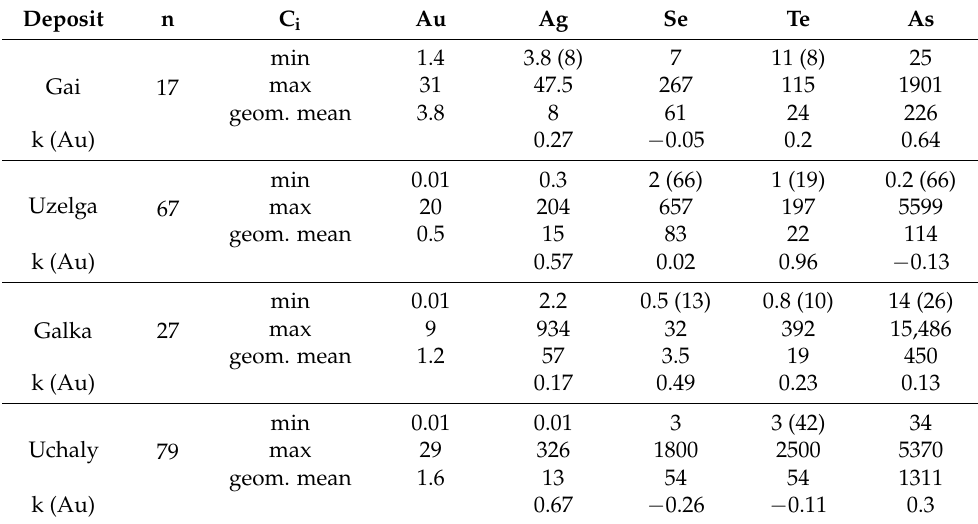
Table 19. Contents of Au, Ag and some impurities in pyrite of VMS deposits according to LA-ICP-MS data (ppm).